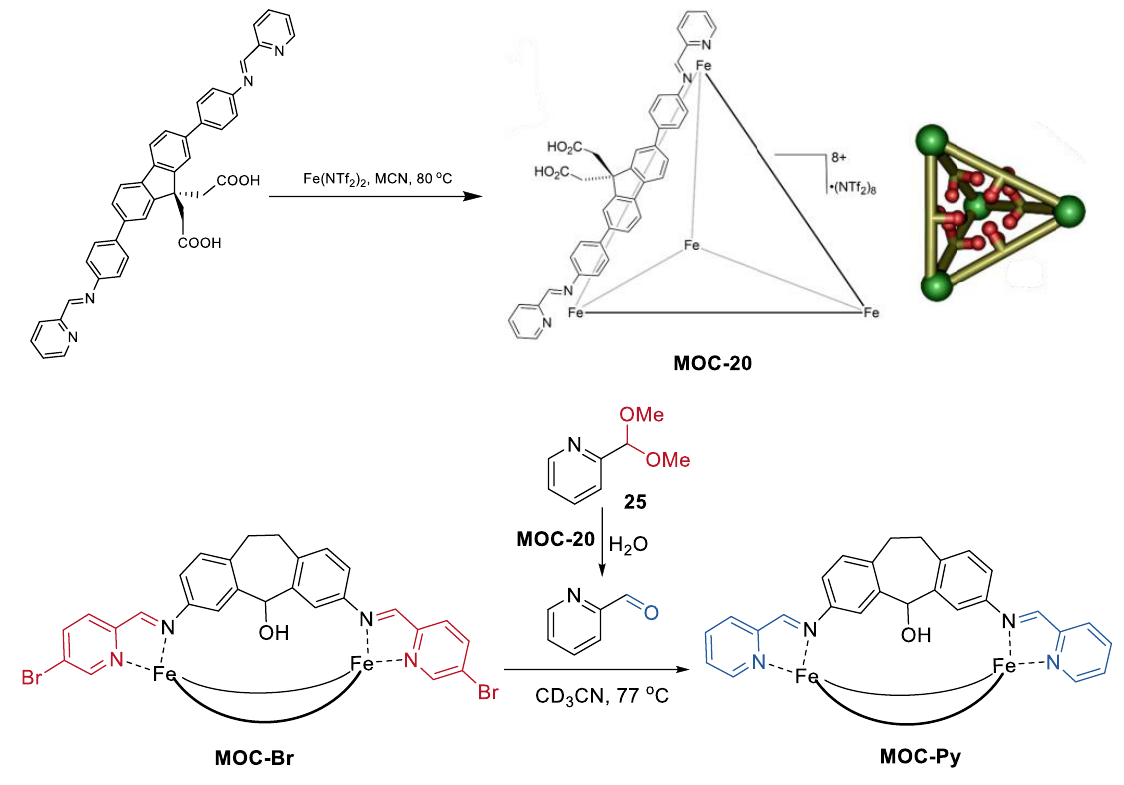
Figure 20. Tandem acetal hydrolysis/cage-to-cage interconversion catalyzed MOC-20 [93]. Reaction conditions: 25 (12.3 mM), MOC-20 (34 mol%), MOC-Br (1.5 mM) H 2 O, CD 3 CN. Reprinted/adapted with permission from Ref. [93]. Copyright 2018 American Chemical Society.